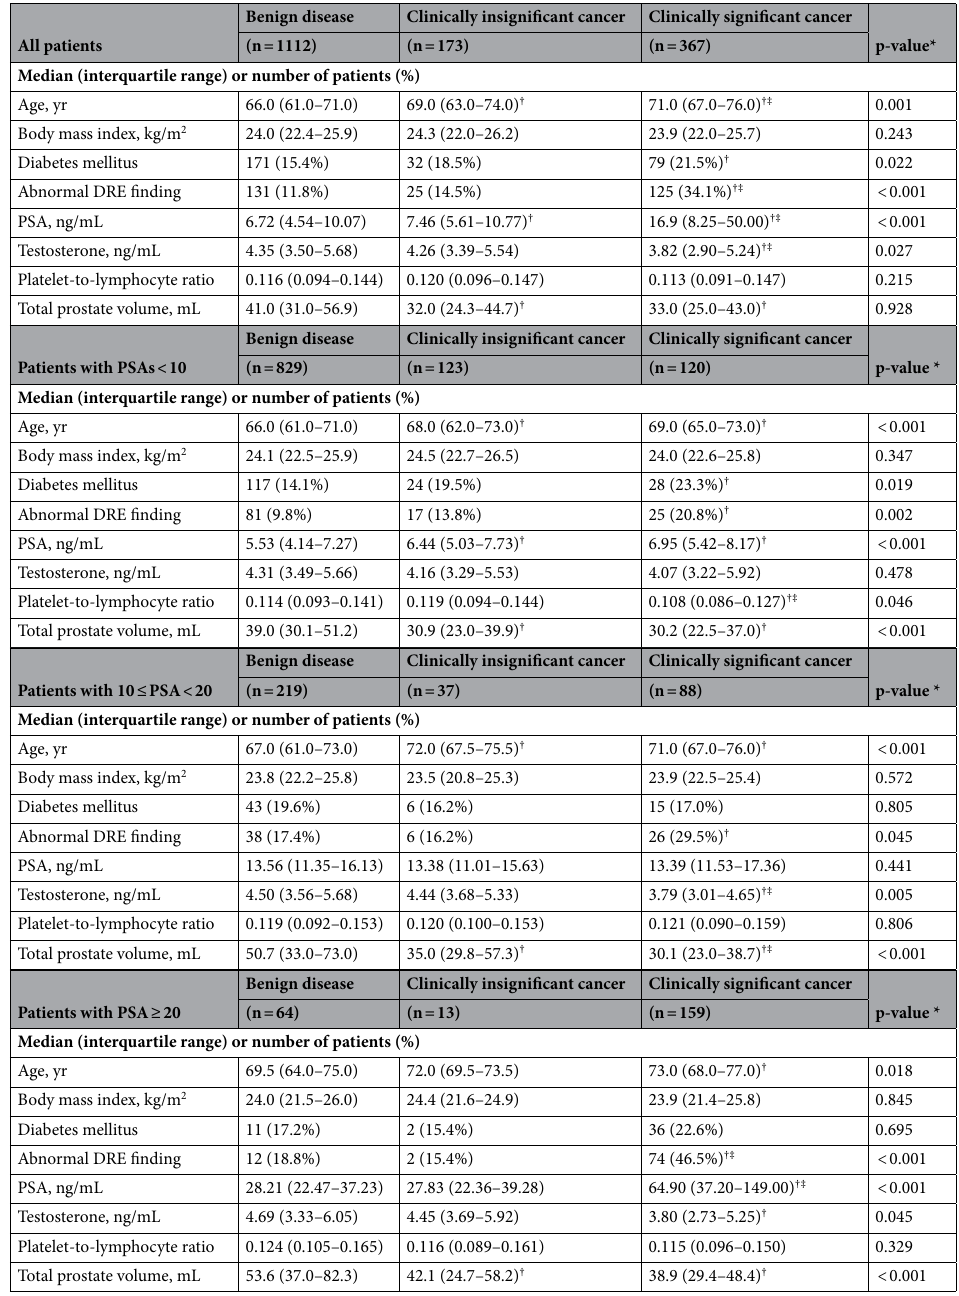
Table 2. Comparison of explanatory variables between the patients with benign disease, clinically insignificant cancer, and clinically significant cancer. All variables were presented as median (interquartile range) or the number of patients (%). DRE digital rectal examination, PSA prostate-specific antigen, yr years. *p < 0.05: comparison of the variables between the groups using the Kruskal–Wallis test, the chi-squared test, or Fisher’s exact test, as indicated. † p < 0.05: compared to the group with benign disease using the Mann–Whitney U test, the chi-squared test, or Fisher’s exact test, as indicated. ‡ p < 0.05: comparison between the groups with clinically insignificant cancer and clinically significant cancers using the Mann–Whitney U test, the chi- squared test, or Fisher’s exact test, as